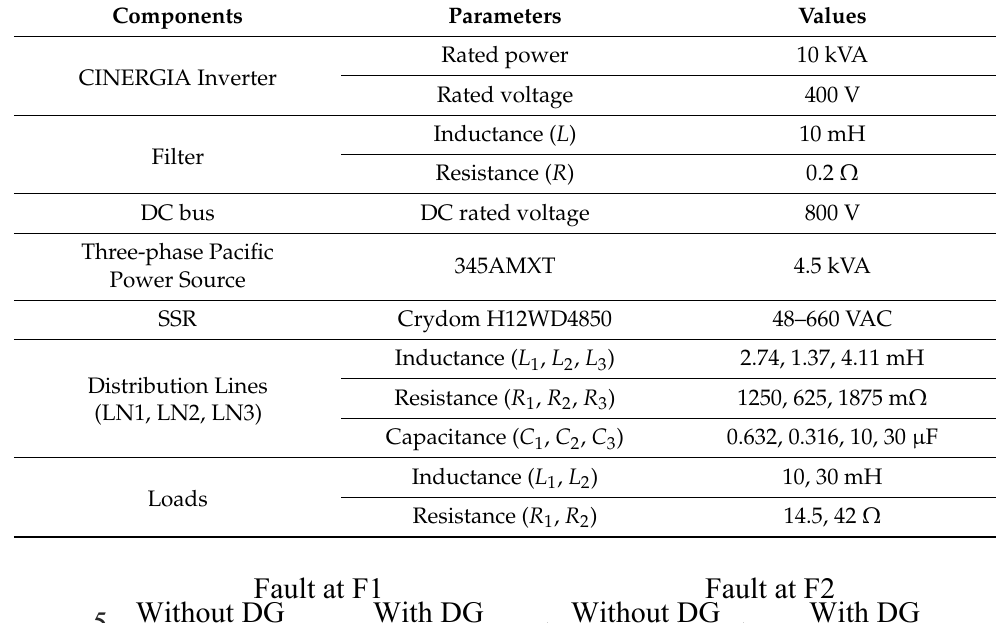
Table 4. System parameters.